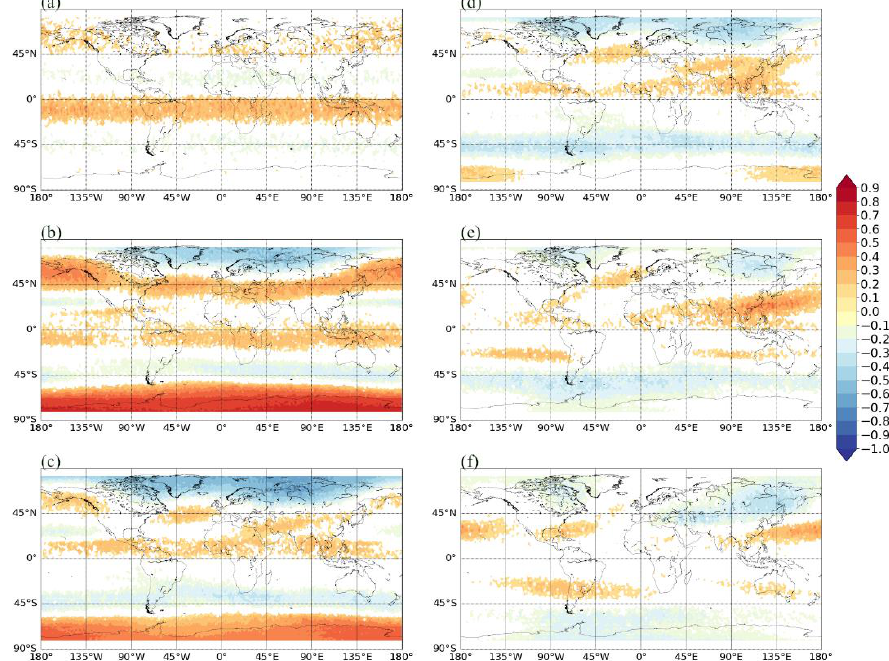
Figure A2. The correlation coefficient (R value) of the monthly average tropical upwelling mass flux at 70 hPa to the local monthly average N 2 O concentration at ( a ) 1 hPa, ( b ) 10 hPa, ( c ) 21.54 hPa, ( d ) 31.62 hPa, ( e ) 46.42 hPa, and ( f ) 68.13 hPa. Only correlation coefficients with a confidence of more than 90% are shown on the graph.